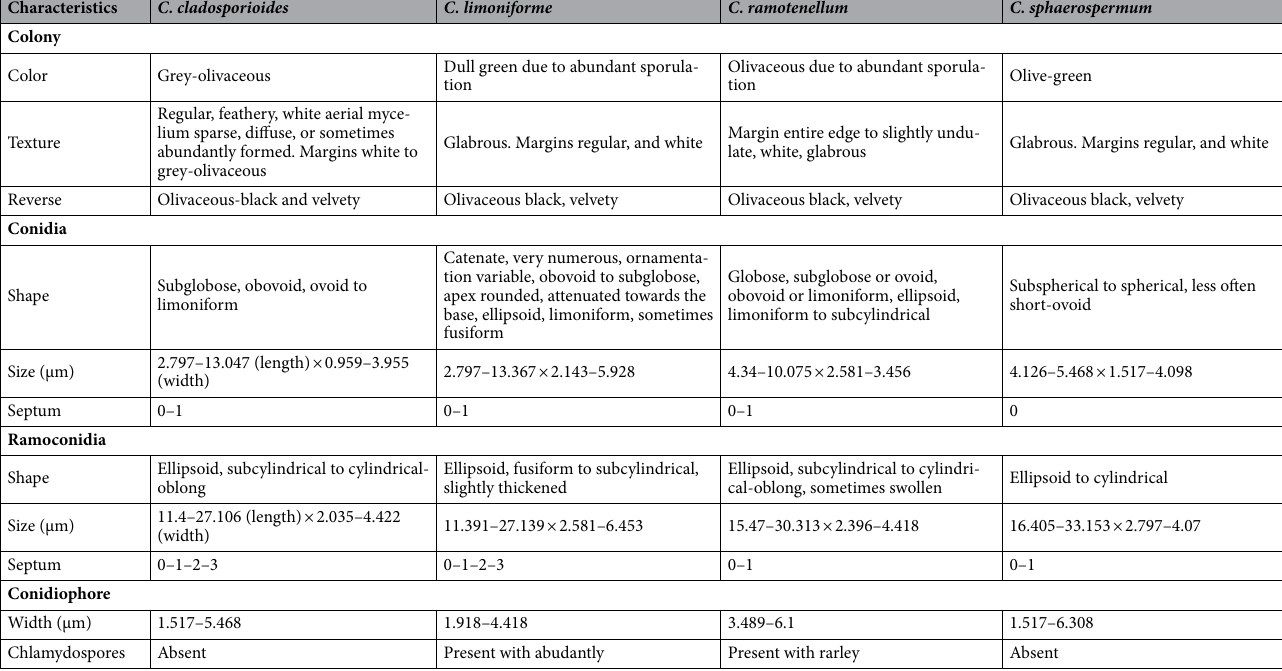
Table 1. Morphological and cultural characteristics of Cladosporium sp. on PDA medium at 28 °C for 7